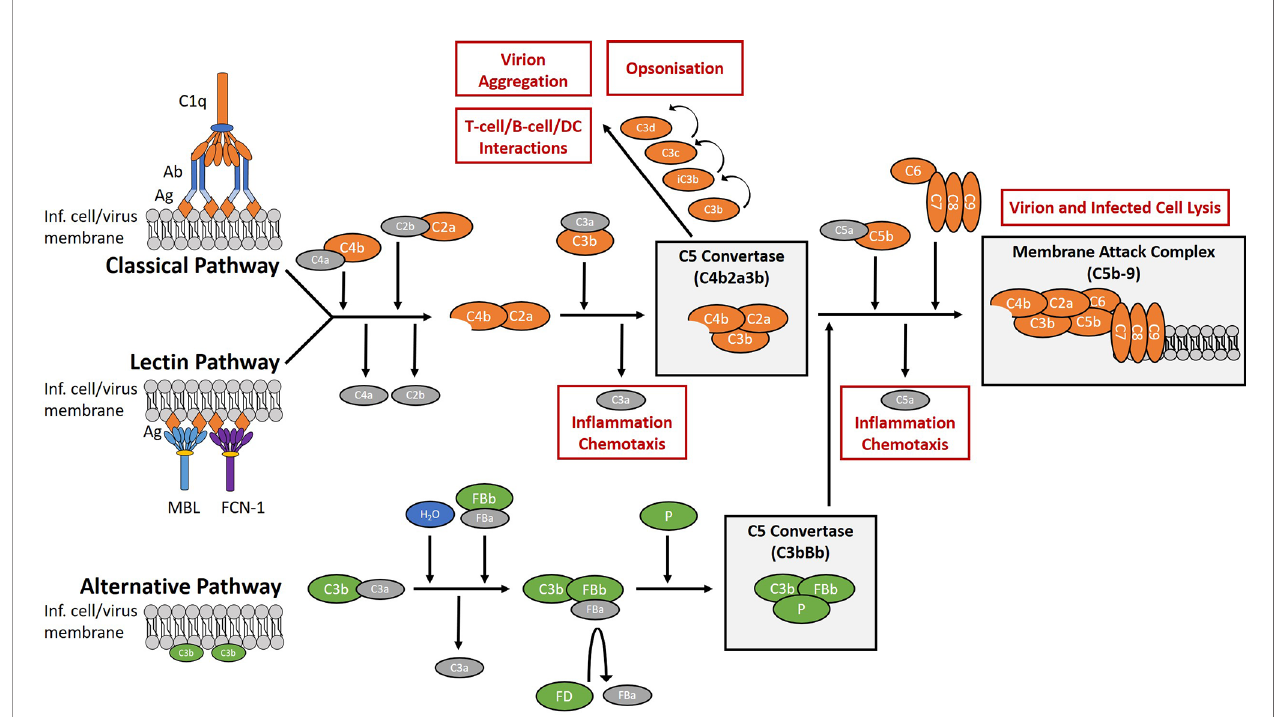
FIGURE 1 | Overview of the complement system. The complement system is a collection of plasma and membrane-bound proteins which form part of the innate immune response against invading pathogens as well as performing other immunological roles. The system can be divided into three pathways (classical, lectin, alternative). The classical pathway is typically antibody-dependent and relies on the binding of C1q protein. The lectin pathway is antibody-independent and utilises lectins such as mannose-binding lectin (MBL) and fi colin-1 (FCN-1) to bind glycosylated regions on the surface antigens of pathogens. The alternative pathway is activated from spontaneous hydrolysis of the C3 protein and an absence of regulatory proteins on the microbial surface. In the context of viral infection, complement activation aims to limit infection through the promotion of in fl ammation and chemotaxis, the opsonisation of virions, the aggregation of virions, the direct lysis of virion and infected cell membranes, and by aiding the development of the adaptive immune response. (Ab), antibody; (Ag), antigen; (DC), dendritic cells; (FB), factor B; (FD), factor D; (FCN-1), fi colin-1; (Inf.), infected; (MBL), mannose-binding lectin; (P),